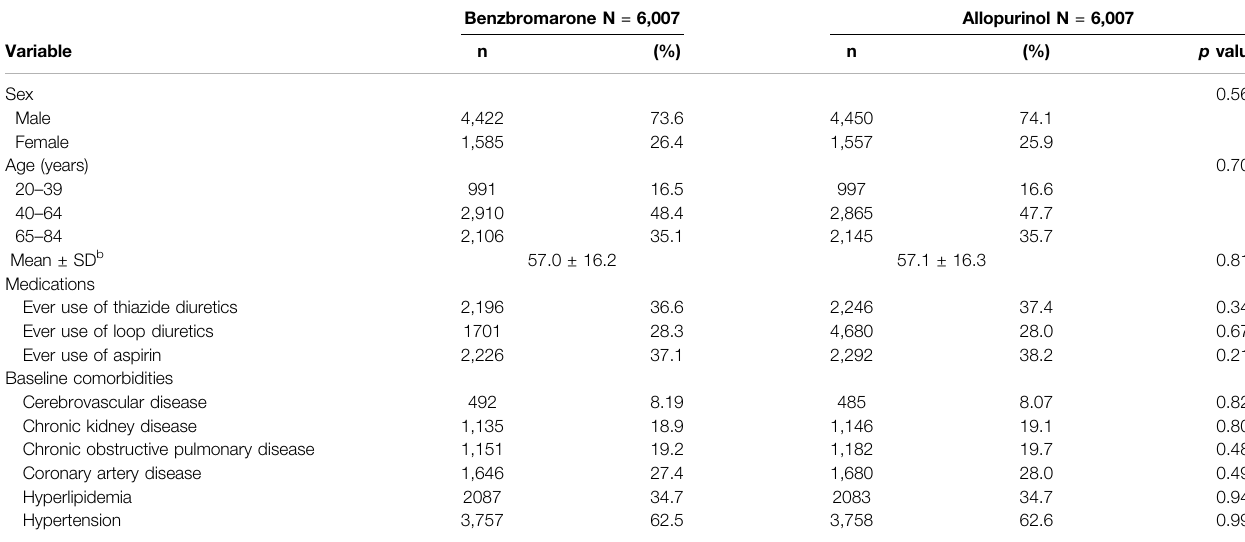
TABLE 1 | Baseline information of study subjects after propensity score